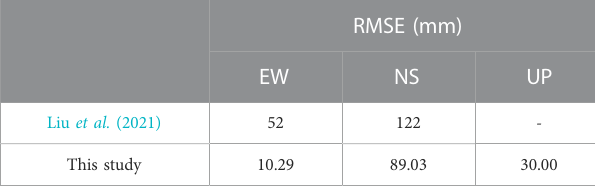
TABLE 2 RMSE of Maduo earthquake determined from different studies.